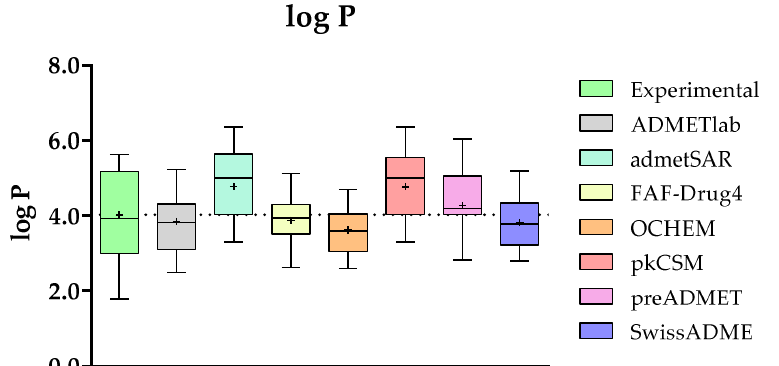
Figure 4. Comparison of the experimental and predicted data for the octanol/water coefficient (log P) between ADMETlab, admetSAR, FAF-Drug4, OCHEM, pkCSM, preADMET, and SwissADME. Statistical analysis was performed by a pairwise t -test ( n = 15) versus experimental data.